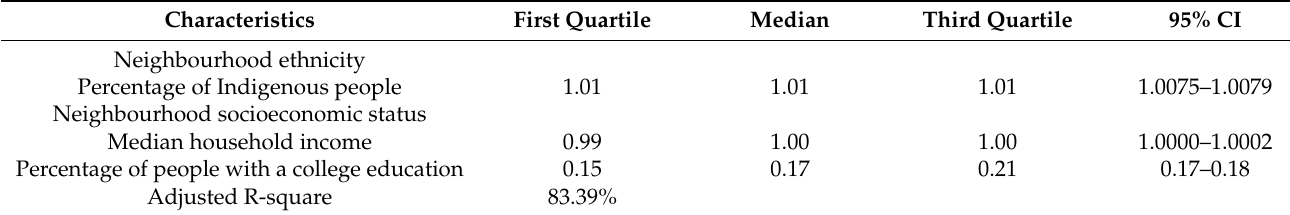
Table 3. Log-transformed age-standardized premature mortality regressed on neighbourhood SDOH using geographically and temporally weighted regression ( n =